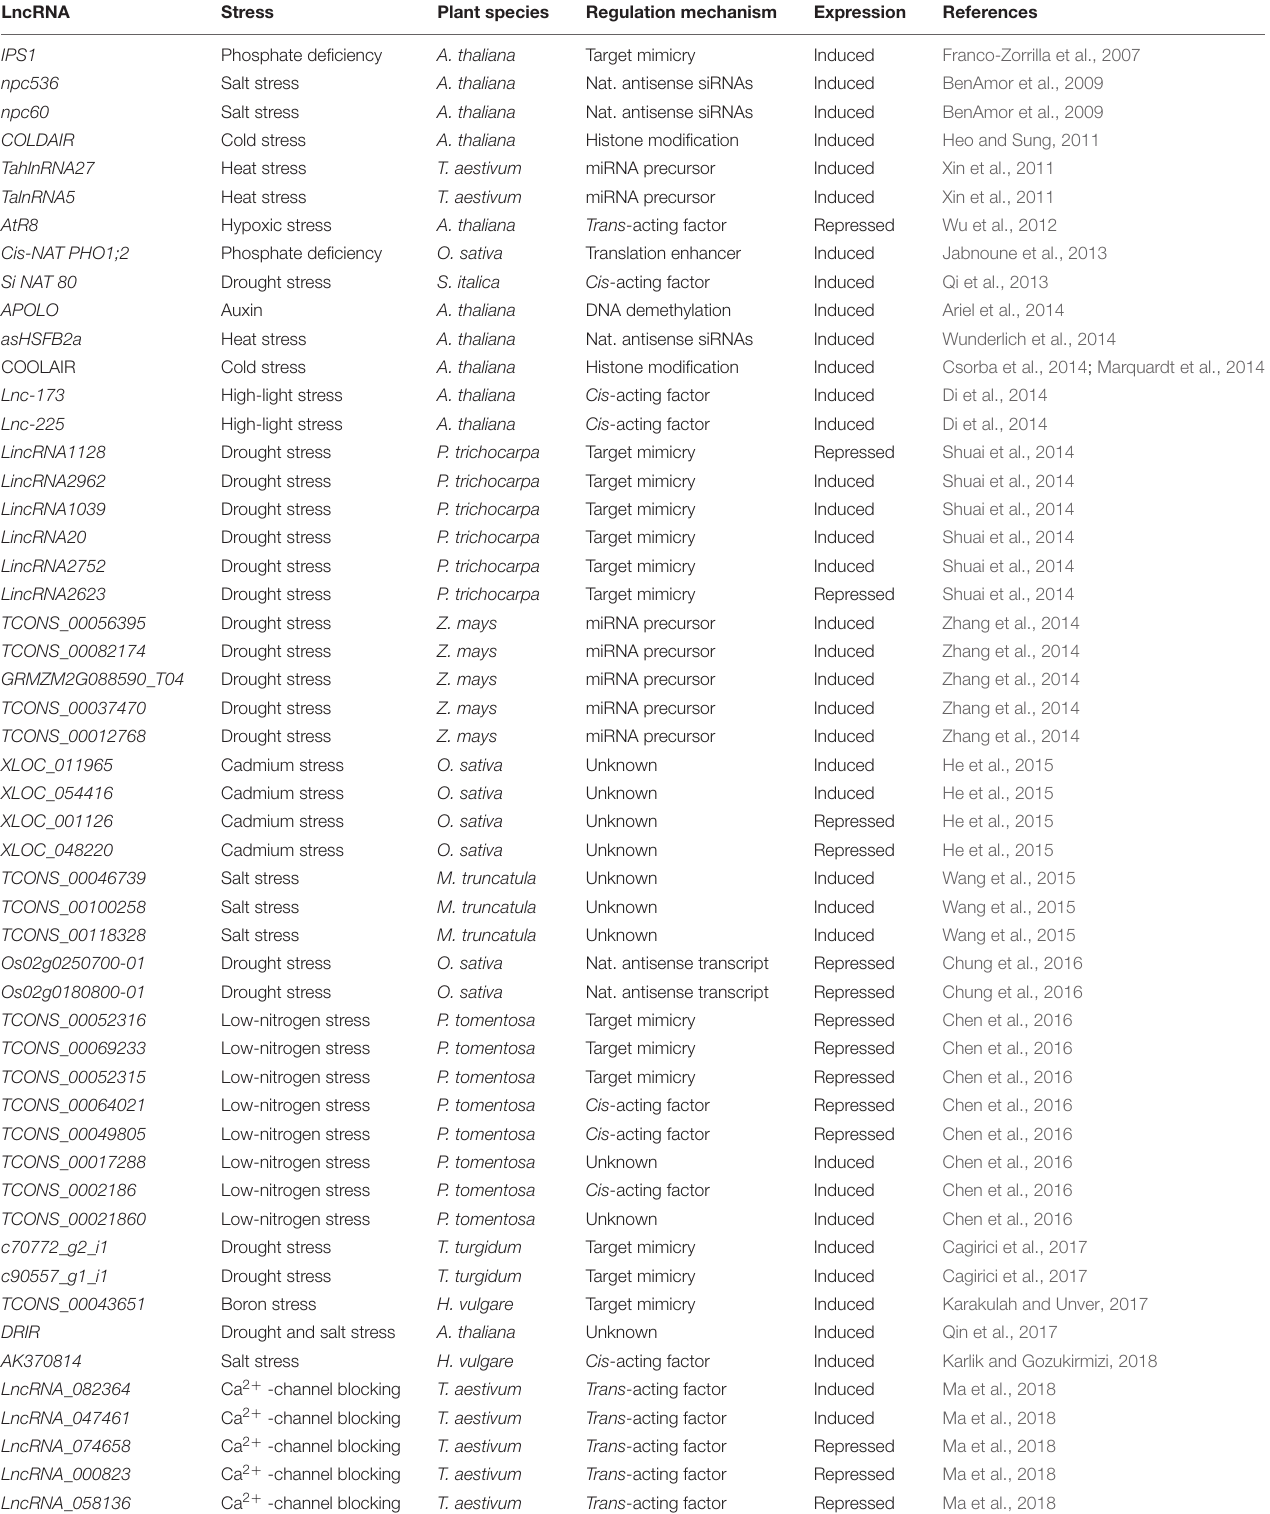
TABLE 1 | Summary of studies with abiotic stress-responsive lncRNAs in plants.